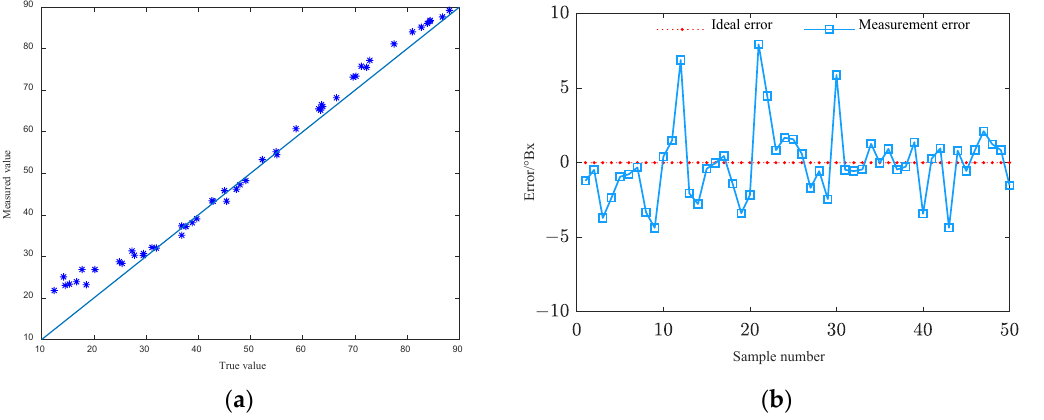
Figure 12. Measurement results of syrup brix based on multiple regression fitting in the independent test set. ( a ) Measurement results of brix; ( b ) Measurement errors of brix. By testing the three calculation models with the experimental dataset, the evaluation indicators in Table 7 can be compared. Table 7. Measurement performance of syrup brix with different calculation models.